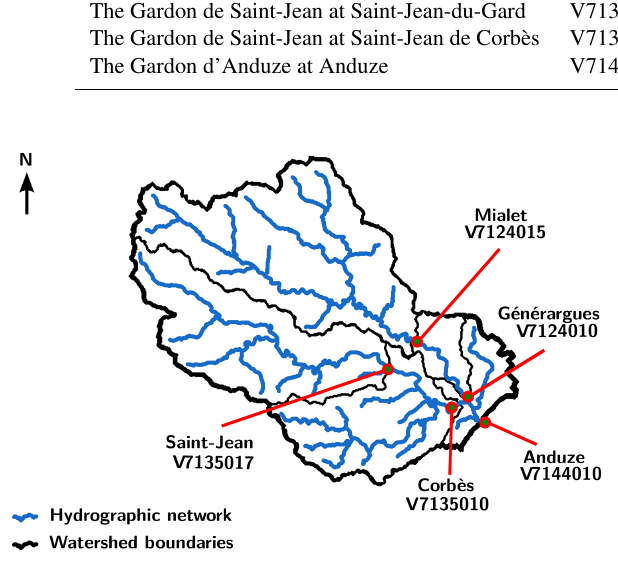
Figure 2. The Gardon watershed at Anduze: hydrographic network (blue) and gauging stations V7124015, V7124010, V7135017, V7135010 and V7144010